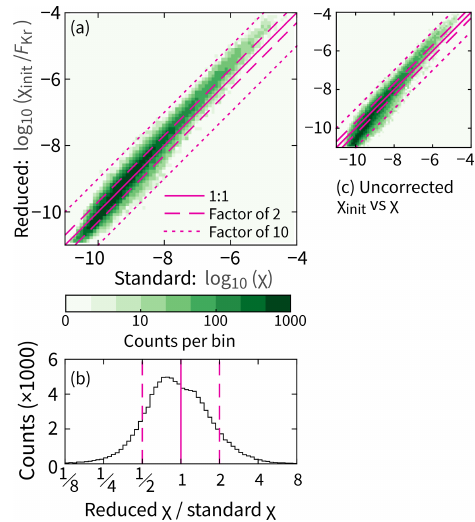
Figure 9. Statistical test of the proposed data reduction scheme for χ . Equivalent to Fig. 6, except for the use of χ instead of (cid:15) . In total, there are 100000 segments of data.